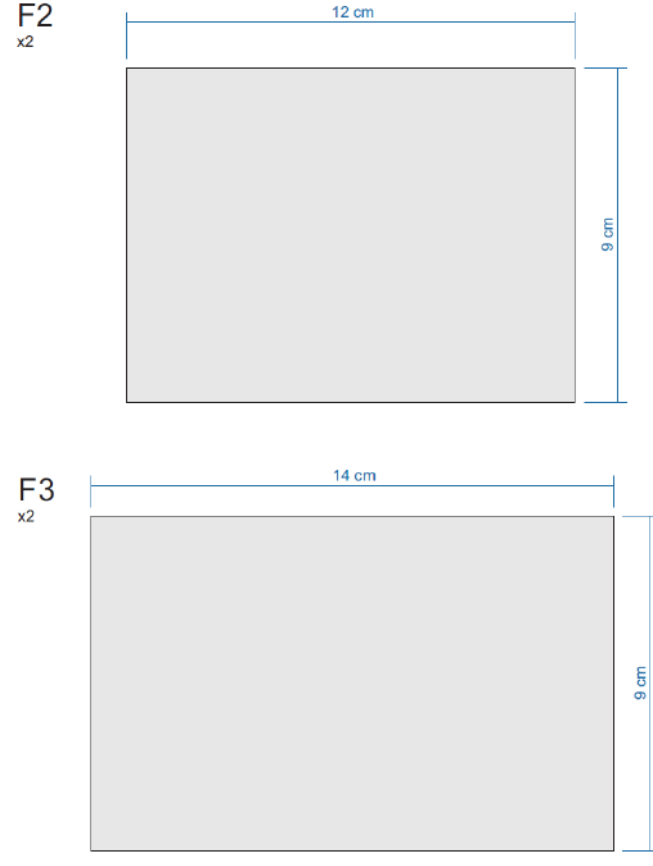
Figure A4. Sections of the